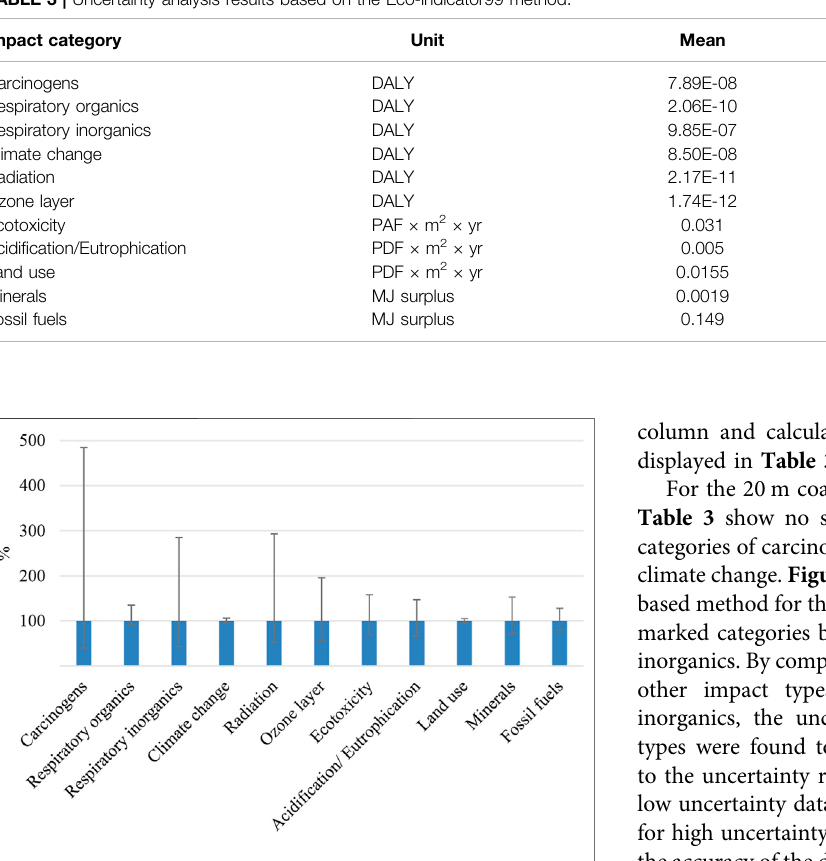
TABLE 3 | Uncertainty analysis results based on the Eco-indicator99 method.